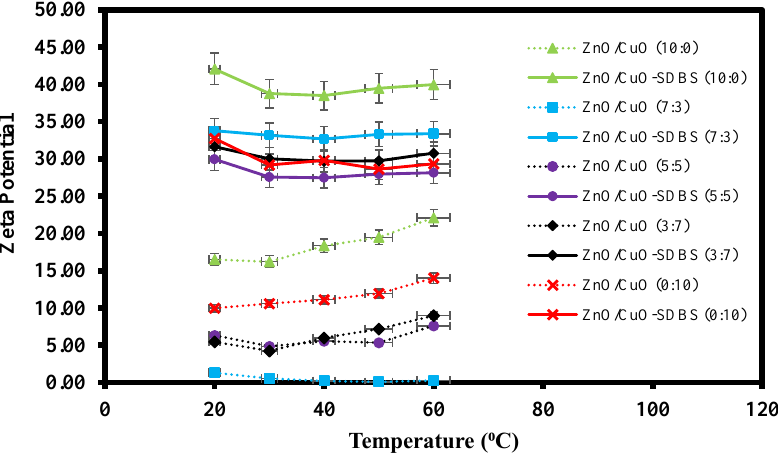
Figure 10. Zeta potential measurement of ZnO-CuO/water hybrid nanofluids at different mixing ratios.